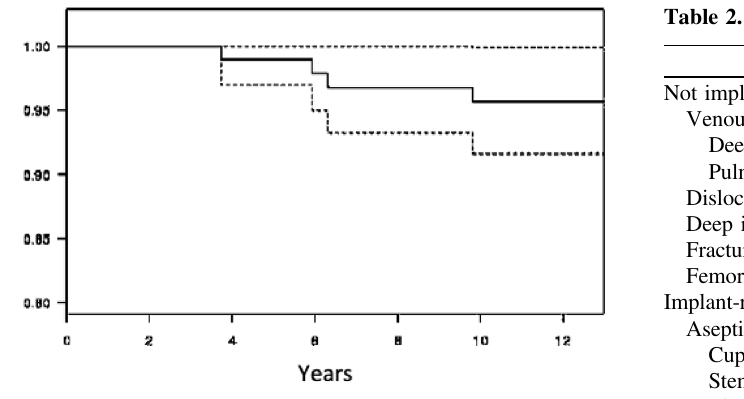
Figure 3. Survivorship aseptic loosening of aseptic loosening using Kaplan-Meier.